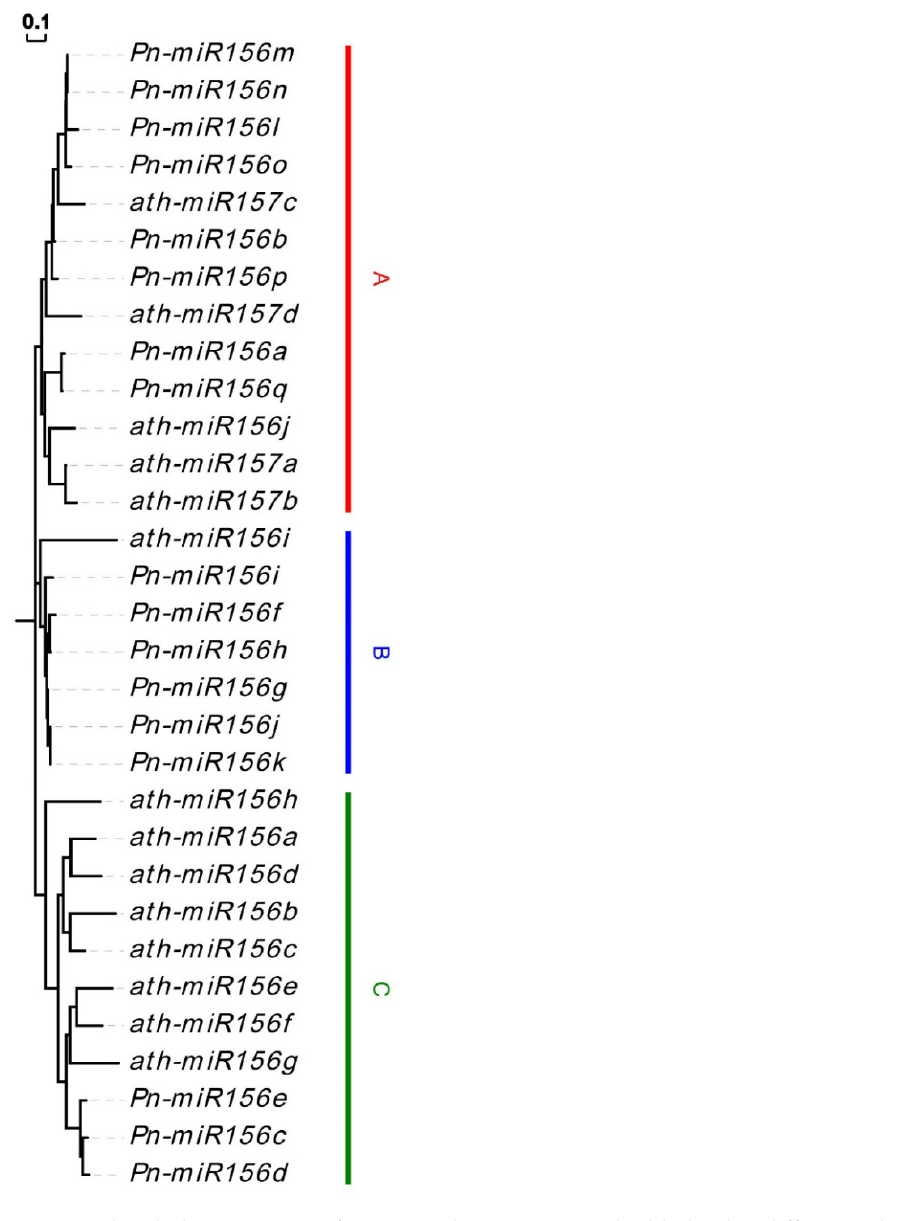
Figure 6. The phylogenetic tree of miR156s, three groups are highlighted in different color stripes. The A. thaliana sequences start with ath- and the pepper sequences start with Pn-. Three phylogenetic groups were marked by ( A – C ).